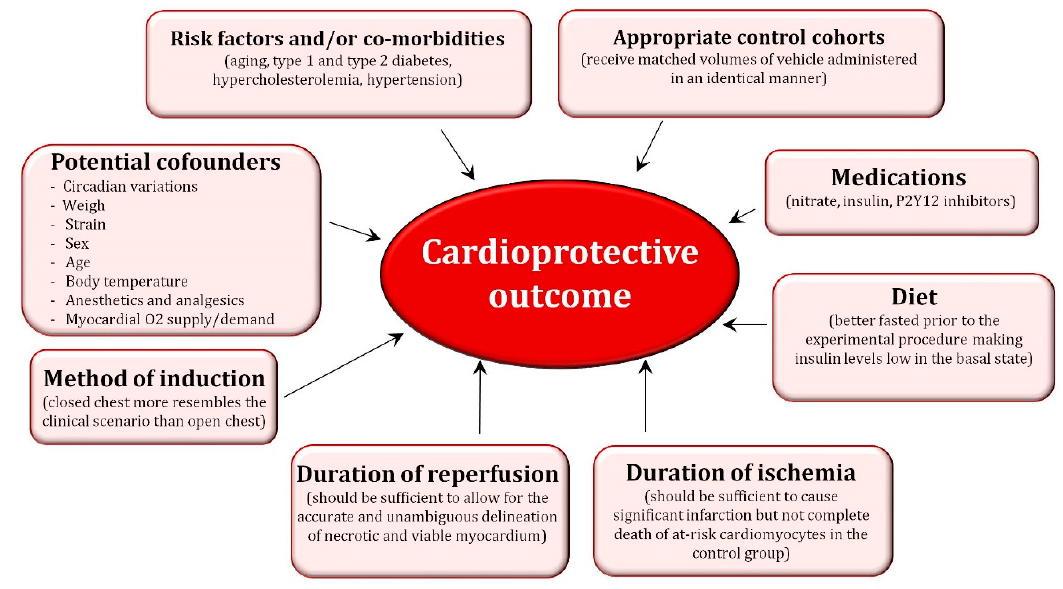
Figure 2. Factors that may contribute to the cardioprotective outcome.